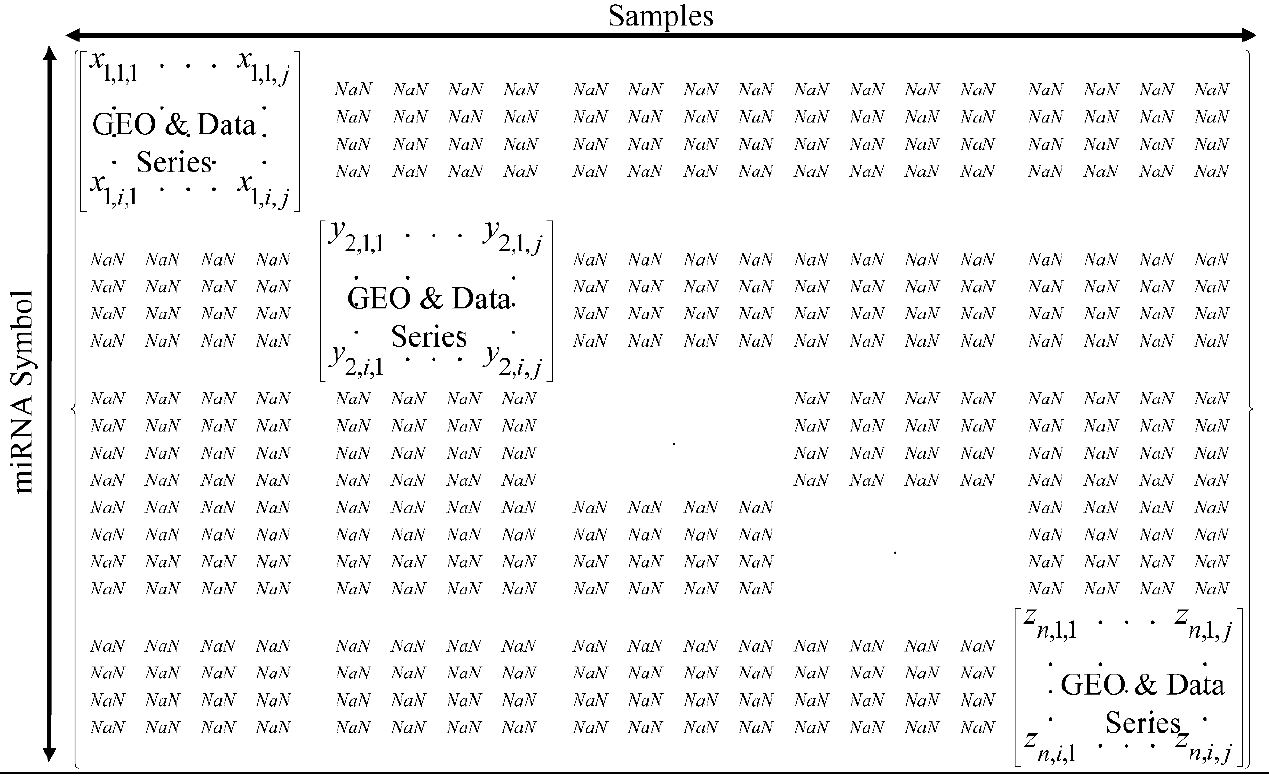
Figure 1. The hyper-matrix containing all data series for further processing, where n is the data series, i is the miRNA and j the respective sample.